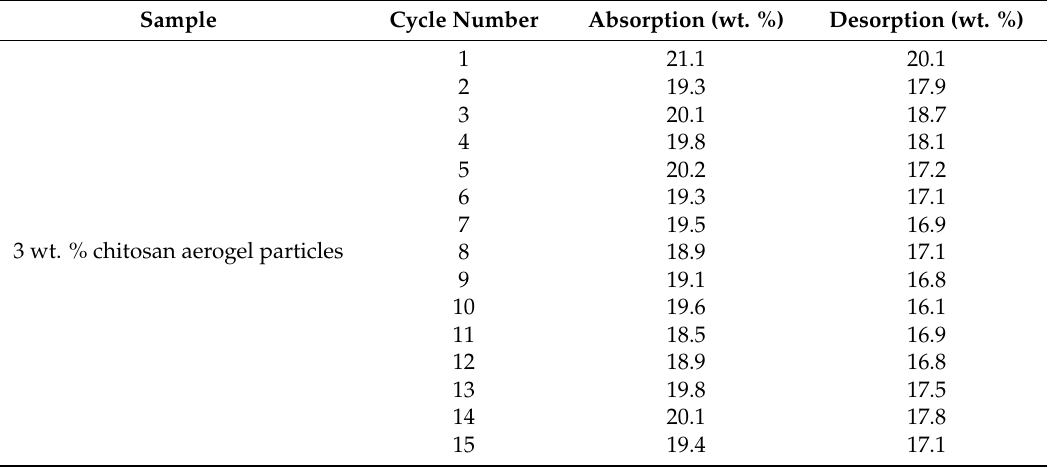
Table 6. Absorption and desorption behavior of 3 wt. % chitosan aerogel particles. Sample Cycle Number Absorption (wt. %) Desorption (wt. %)